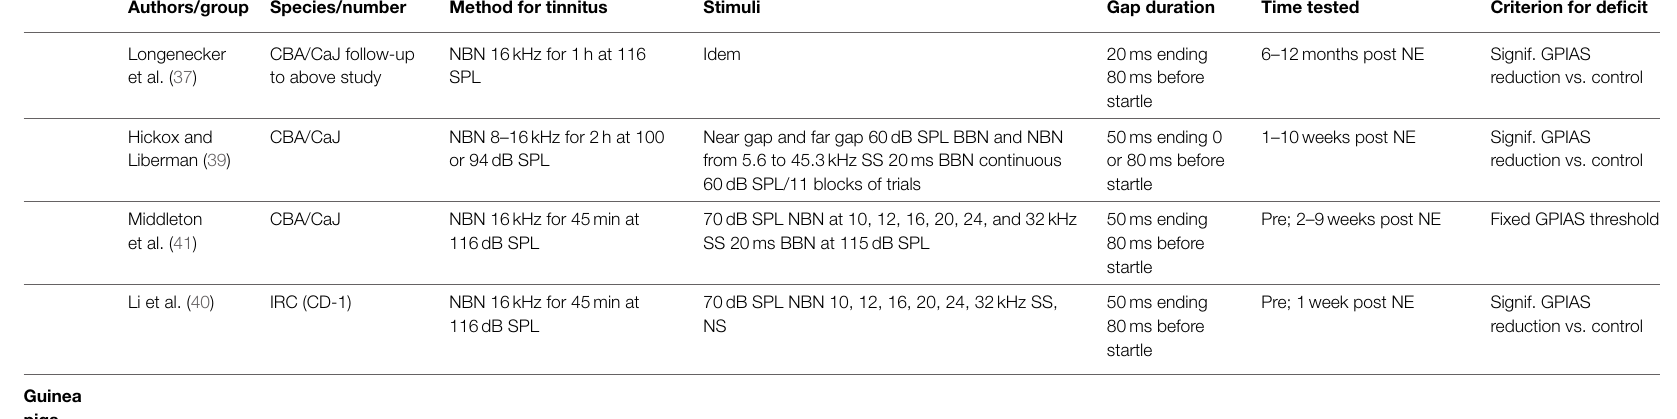
Signif. GPIAS reduction vs. control